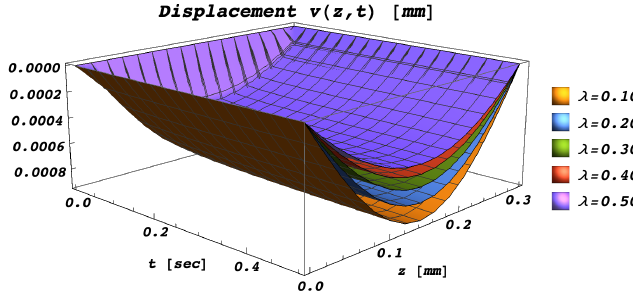
Figure 3. Displacement for different values of λ